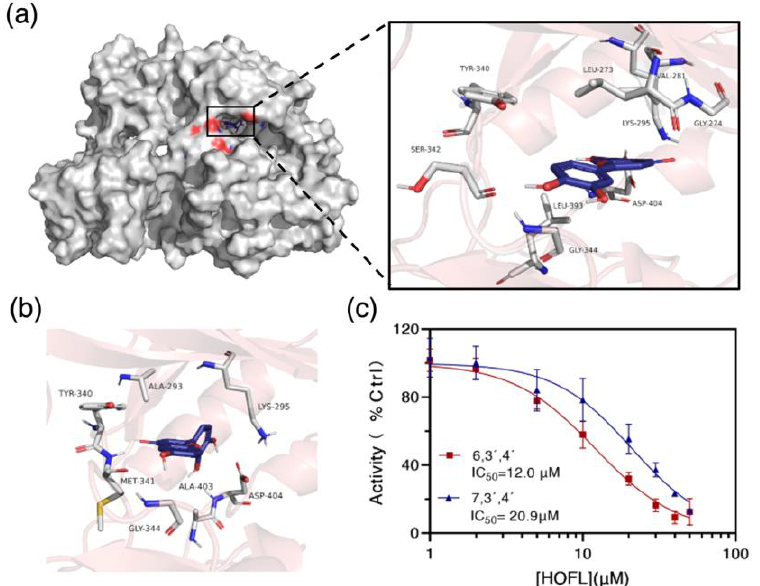
Figure 7 . The binding target of 6,3´,4´- and 7,3´,4´-HOFL. Computational modeling of 6,3´,4´-HOFL bonded to the ATP-binding pocket on the c-Src ( a ); the detailed binding scenario of 7,3´,4´-HOFL ( b ); and dose – response curves of 6,3´,4´- and 7,3´,4´-HOFL on c-Src activity ( c ). Data are shown as mean ± SD, n =